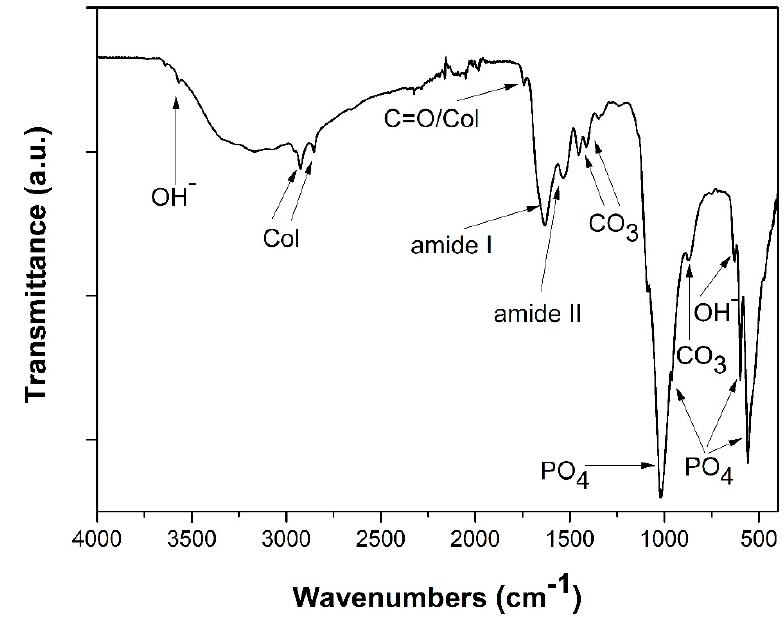
Figure 3. FT-IR spectra of hydroxyapatite (HAp)-Col-Arg samples developed through a bioinspired